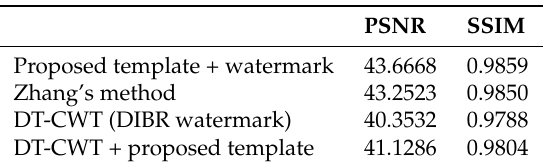
Table 1. Average PSNR and